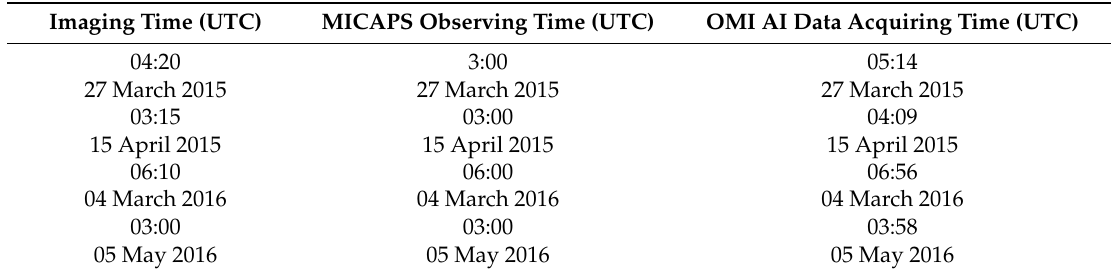
Table 4. Dust storm image and estimation data acquiring times.